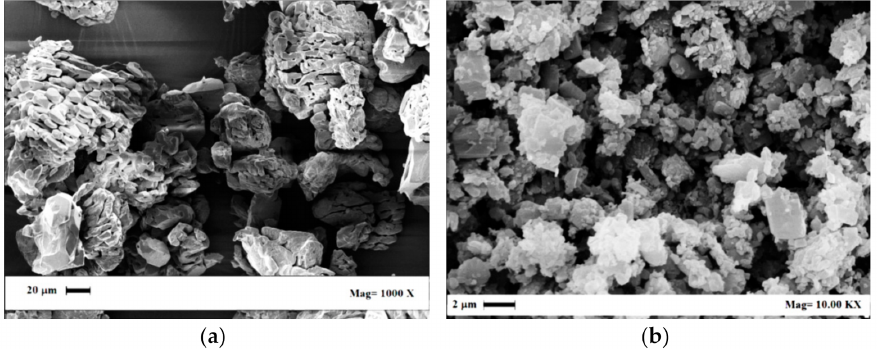
Figure 7. SEM images of the solid materials after the supercritical extraction process: ( a ) Fluni and ( b ) Fluti.